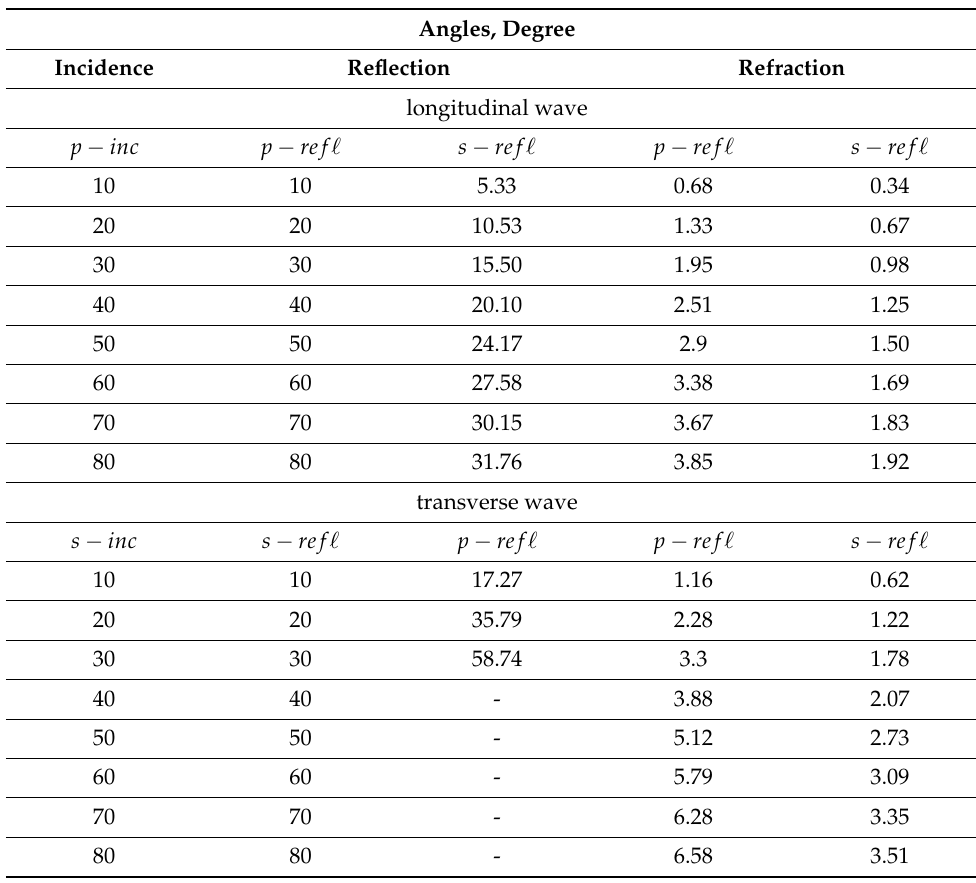
Table 2. Characteristics of the angles of the wave process in the contact pair of the rail-pad for the first option. Angles, Degree Incidence Reflection Refraction longitudinal